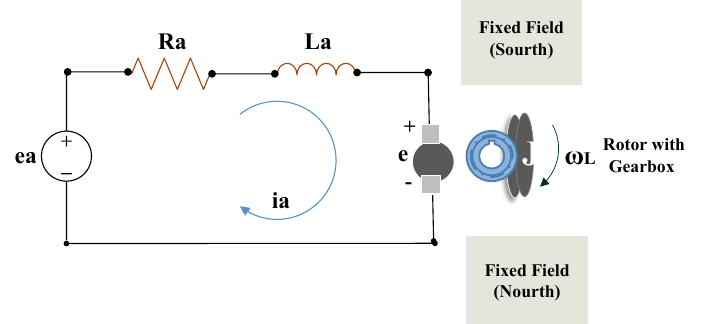
Figure 3. The schematic diagram of the DC motor.